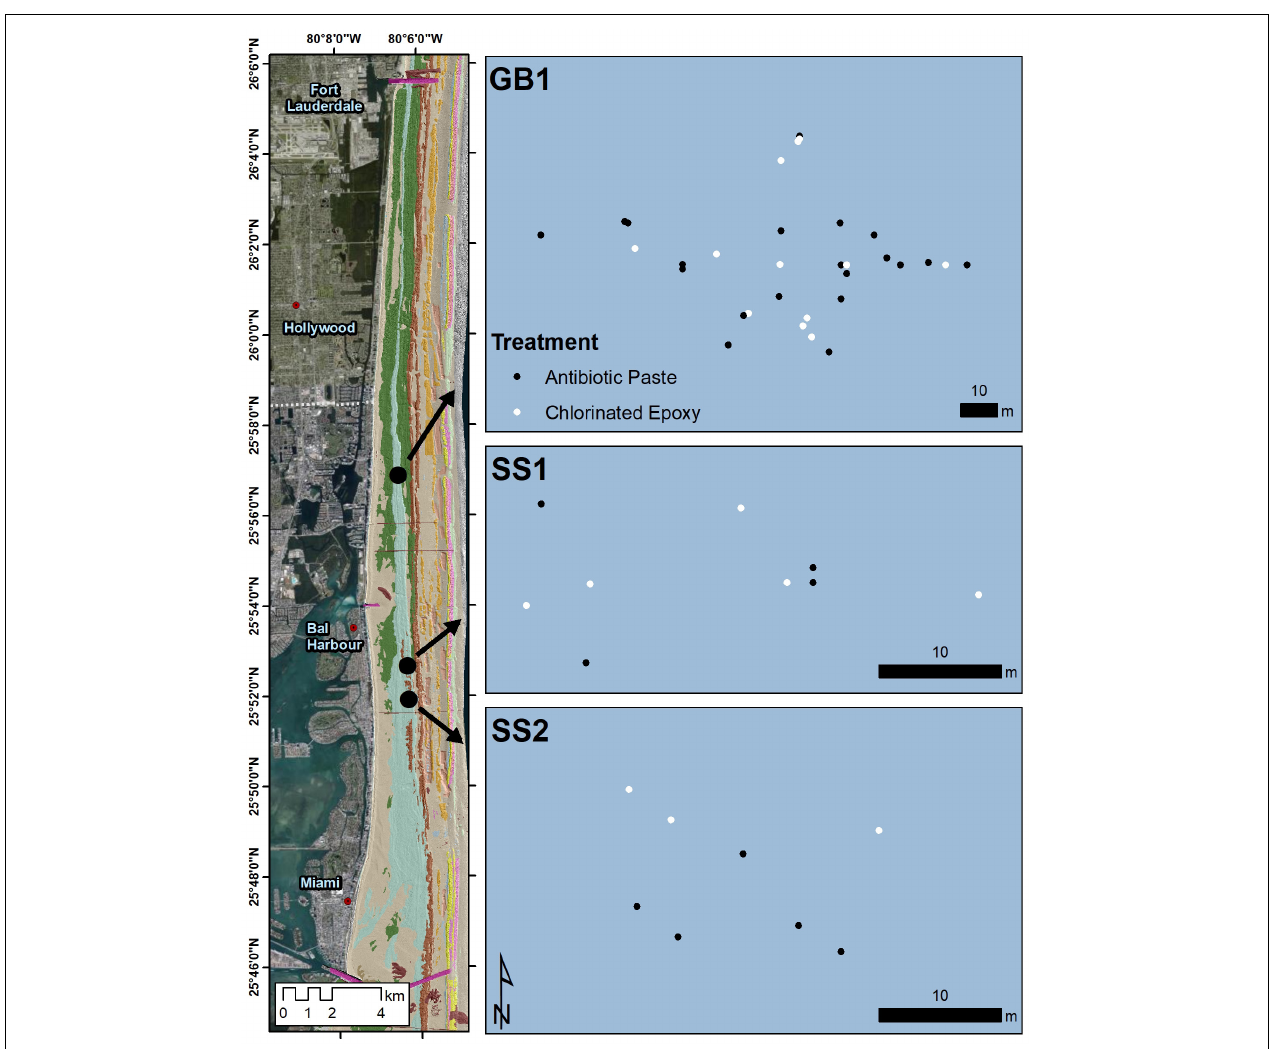
FIGURE 1 | Map of the M. cavernosa corals at the three northern Miami-Dade County treatment sites. Black dots and gray dots represent corals treated with antibiotic paste or chlorinated epoxy